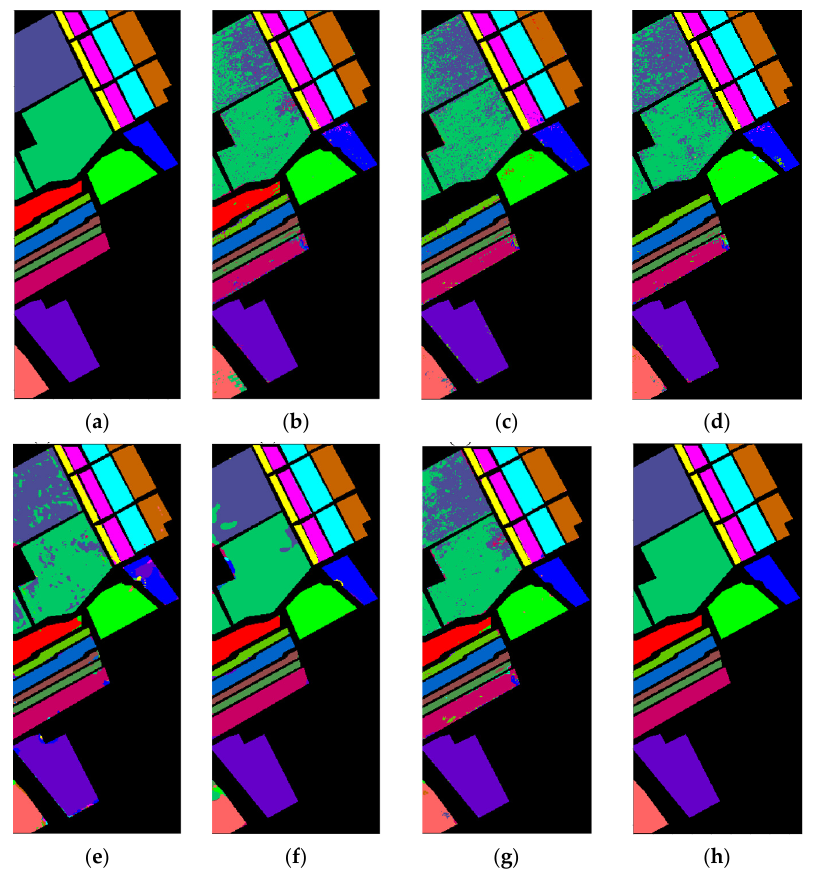
Figure 6. Visualization of the classification results for the Salinas dataset. ( a ) Ground Truth. ( b ) RBF-SVM. ( c ) DBN. ( d ) SAE. ( e ) CNN. ( f ) 3DCNN. ( g ) PPF-CNN. ( h ) ARL-GAN.